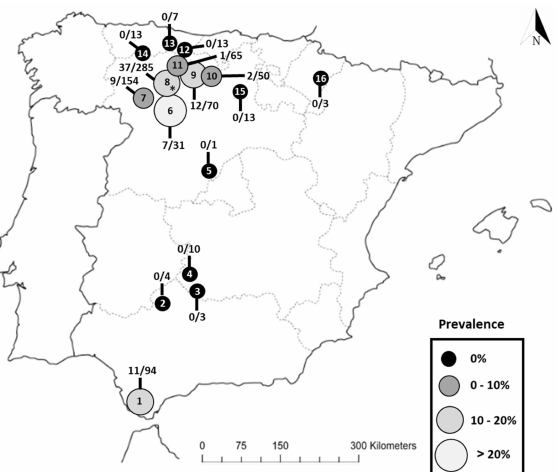
Figure 1. Spatial distribution and prevalence of Coxiella burnetii DNA in spleen samples from micromammals. Each dot (overall sample size included) represents a surveyed population of micromammals. The numbers shown per location indicate the number of positive samples with respect to local sample size (positives/total). The size and color of the dots show population prevalence of C. burnetii infection as detailed in the legend. The asterisk (*) in a dot indicates that a C. burnetii genotype was obtained in this